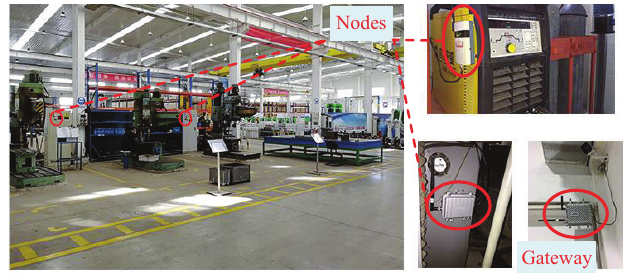
Figure 9. Experimental environment and deployment of field devices.